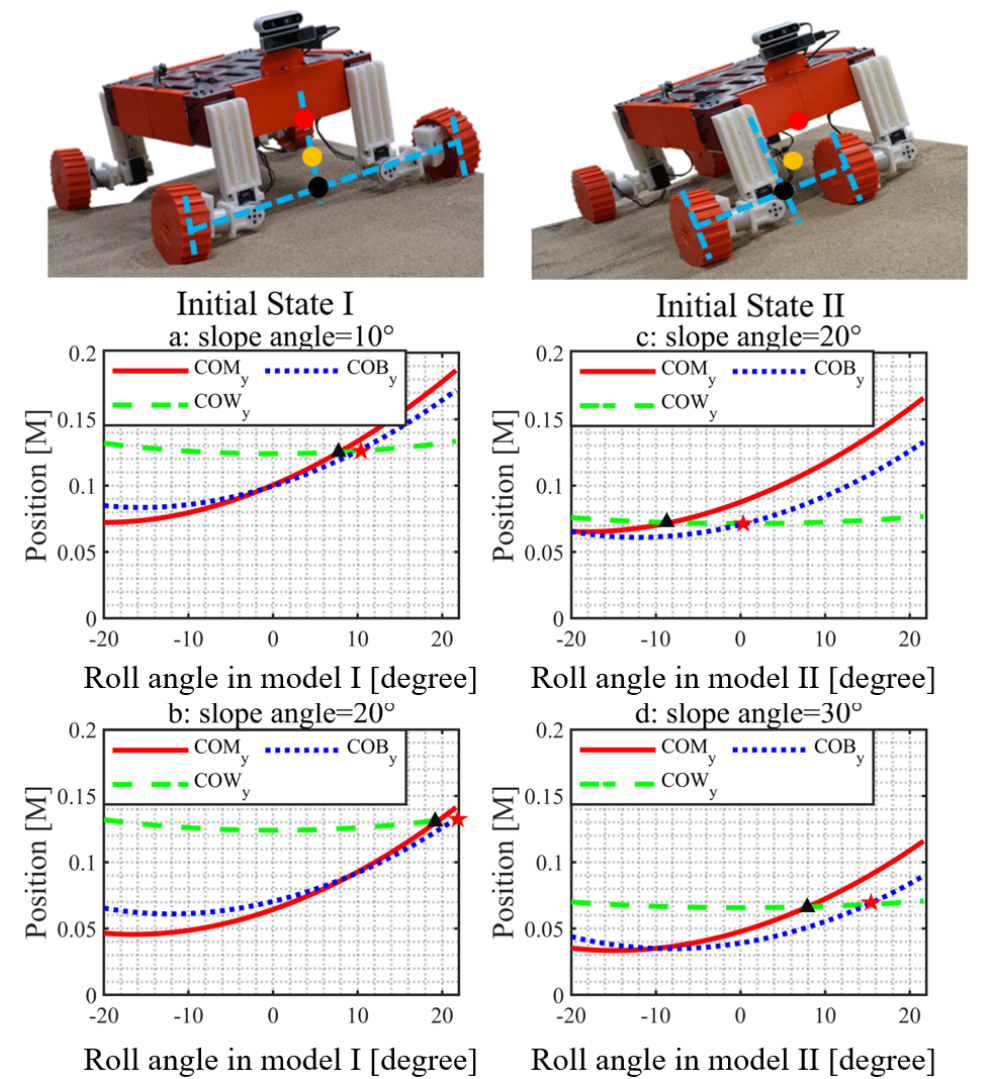
Figure 4. The relations between the rover roll angle and the COM, COB, and COW positions in Y W direction when rover operates in different driving modes. The black triangle refers to the cross of green dash line ( COW y ) and red solid line ( COM y ) ; The red star refers to the cross of green dash line ( COW y ) and blue dotted line ( COB y ). For situation a, the condition is that the rover traverses 10 ◦ slope in mode I, while the slope angle is 20 ◦ for situation b. For situation c, the condition is that the rover traverses 20 ◦ slope in mode II, while the slope angle is 30 ◦ for situation